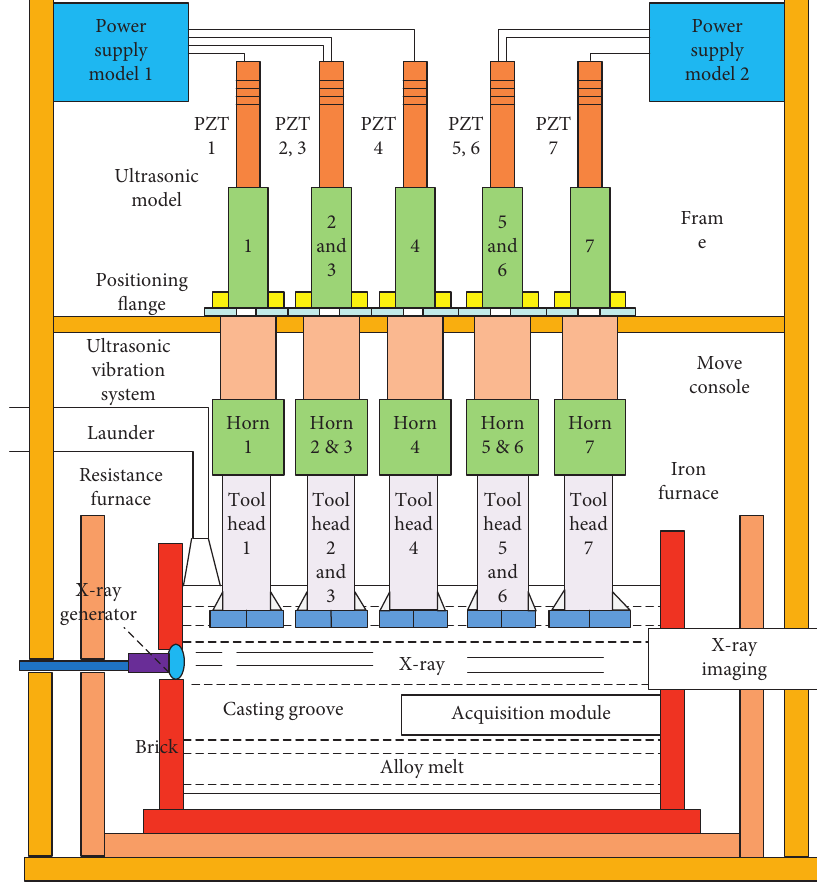
Figure 8: Experimental device of Honeycomb ultrasonic-assisted